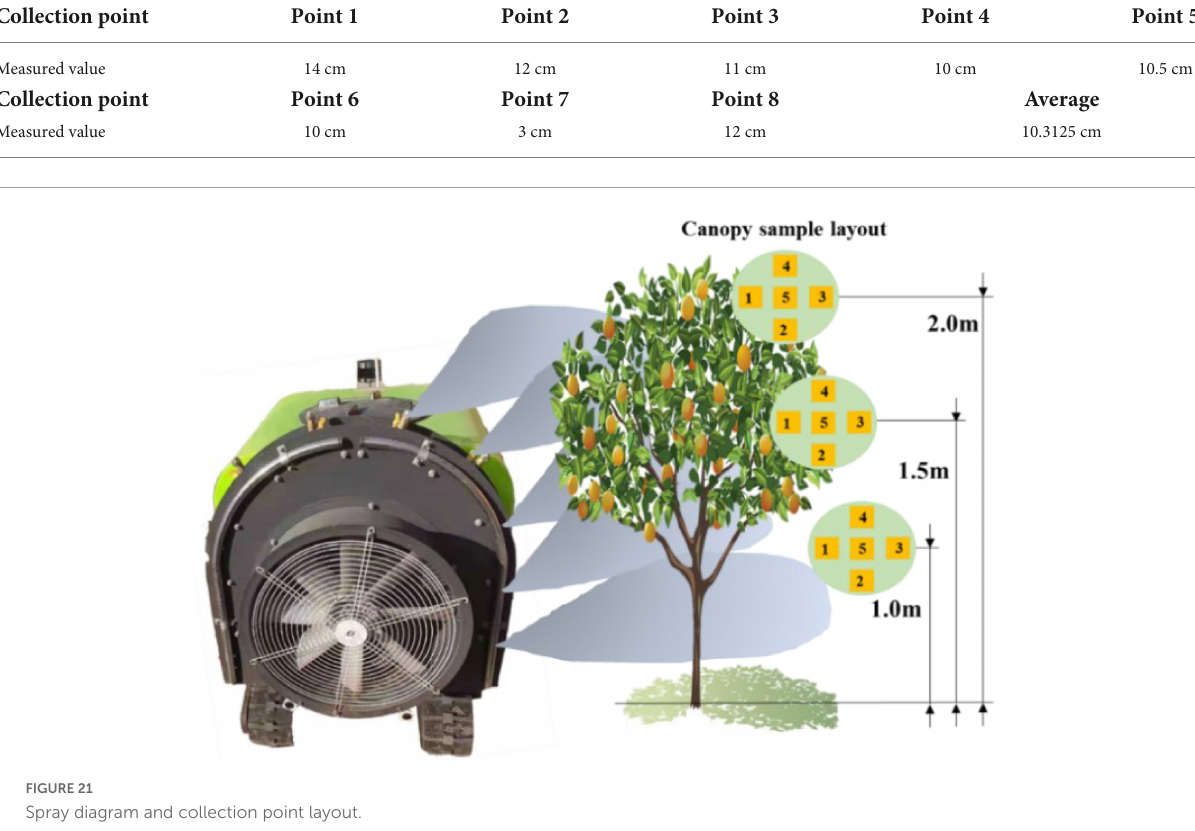
FIGURE21 Spray diagram and collection point layout.